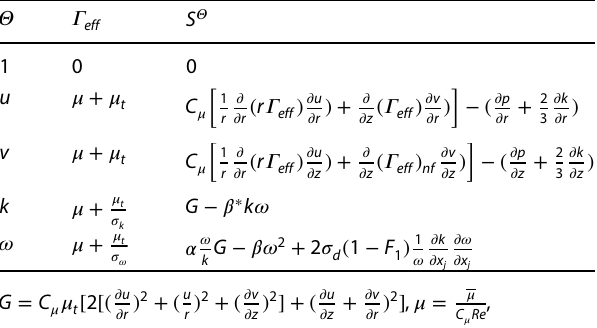
Table 2 The source terms ( S 𝛩 ) for generalized Eq. (1) for SST k −